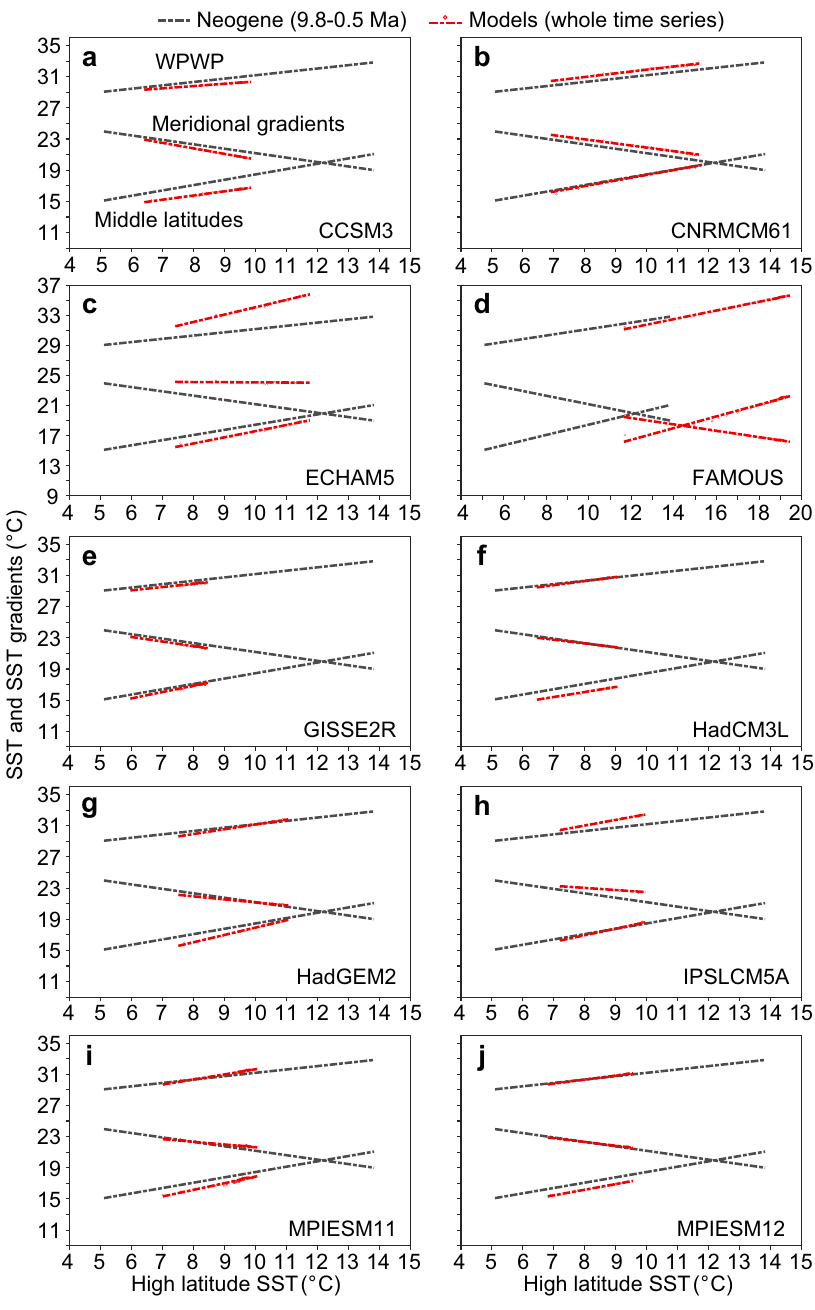
Fig. 6 | Comparing high latitude ampli fi cations determined by the Neogene data to climate models. a – j show the comparison between the Neogene and futureprojection (millennial-length simulations withabrupt 4×CO 2 )from CCSM3, CNRMCM61, ECHAM5, FAMOUS, GISSE2R, HadCM3L, HadGEM2, IPSLCM5A, MPIESM11, and MPIESM12, respectively. Meridional gradients are sea surface tem- perature(SST)differencesbetweentheWesternPaci fi cWarmPool(WPWP)andthe